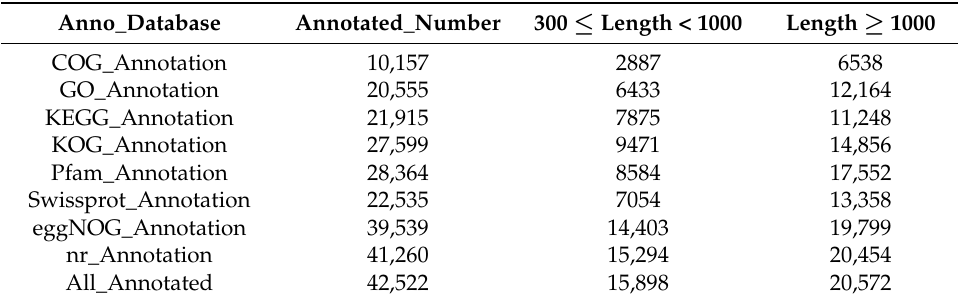
Table 4. Distribution of annotated